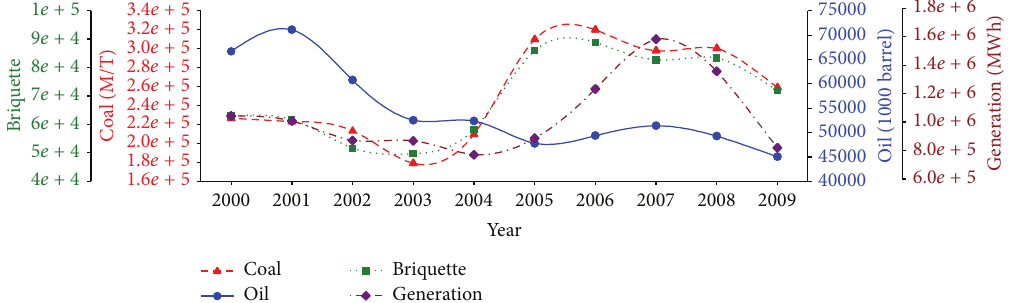
Figure 5: Annual means of coal and oil consumption and yield of briquette and generated.